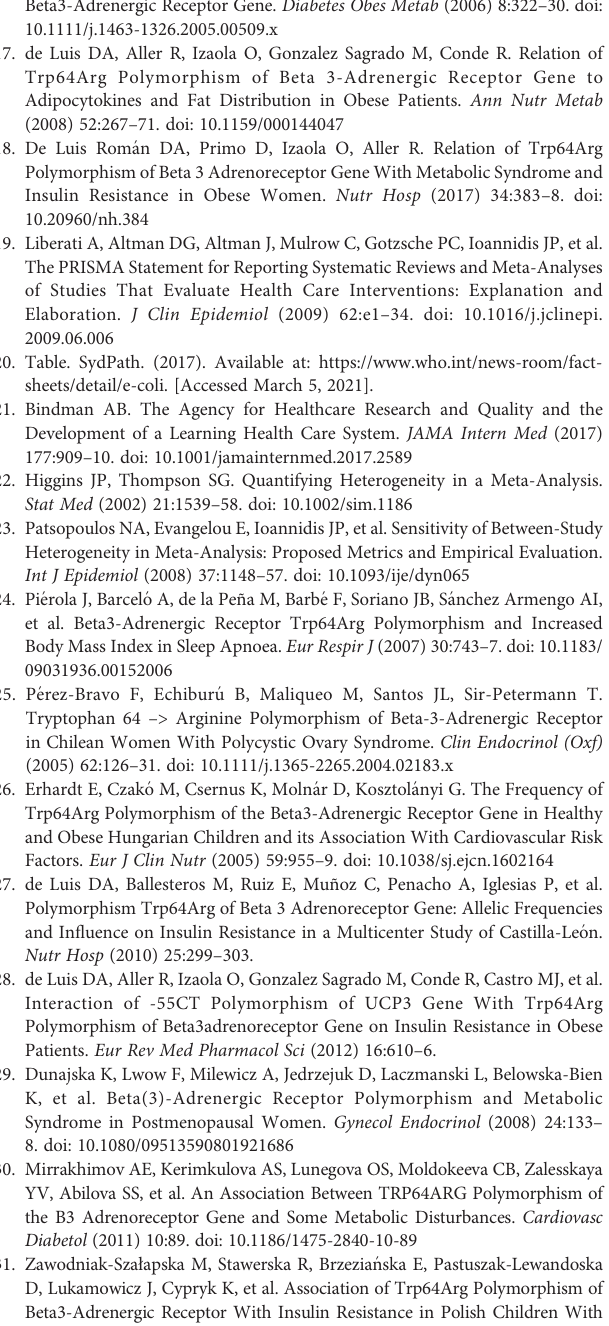
Supplementary Figure 1 | Impact analysis of individual studies. The study by E´ Erhardt had a signi fi cant effect on the pooled result. Supplementary Figure 2 | Forest plot after excluding a single study with high impact. 95% con fi dence intervals ( CI ) are expressed in bars (each group) and diamond (all studies). Summary estimates are analyzed using a random-effects model. SMD, standardized mean difference. Supplementary Figure 3 | Egger ’ s publication bias plot. p